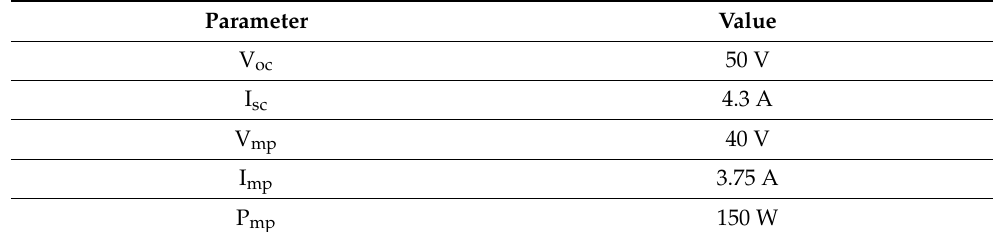
Table 2. Solar PV module